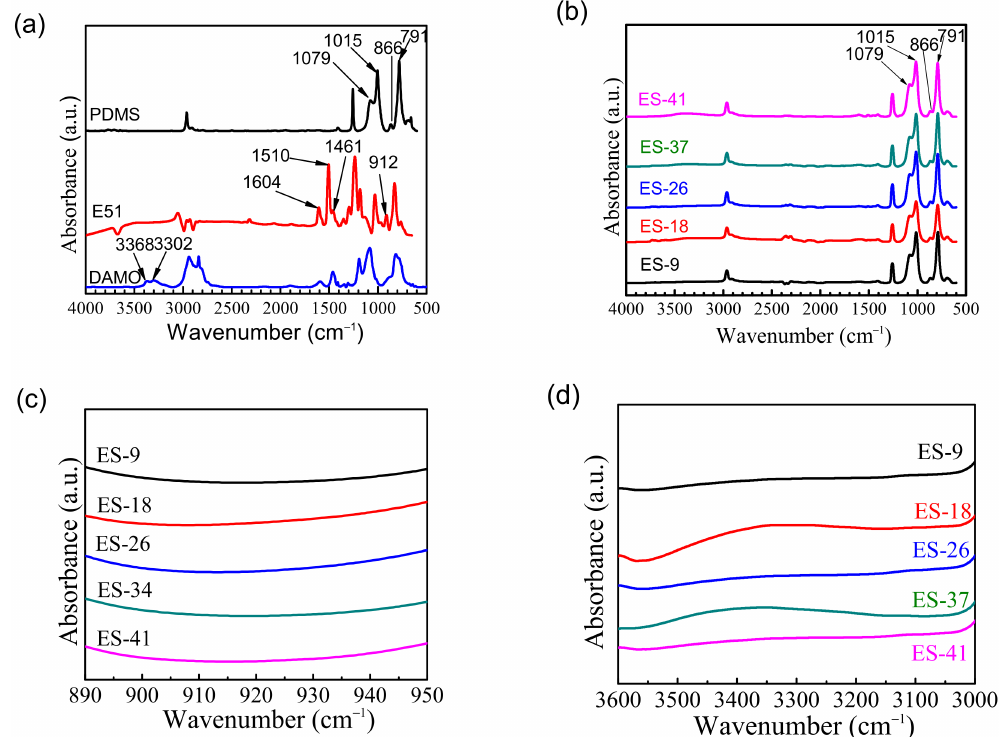
Figure 4. ATR-FTIR spectra of ( a ) main components in the tie-coating; ( b ) binder of tie-coating; ( c ) between 890 cm − 1 and 950 cm − 1 of the binder component; and ( d ) between 3000 cm − 1 and 3600 cm − 1 of the binder